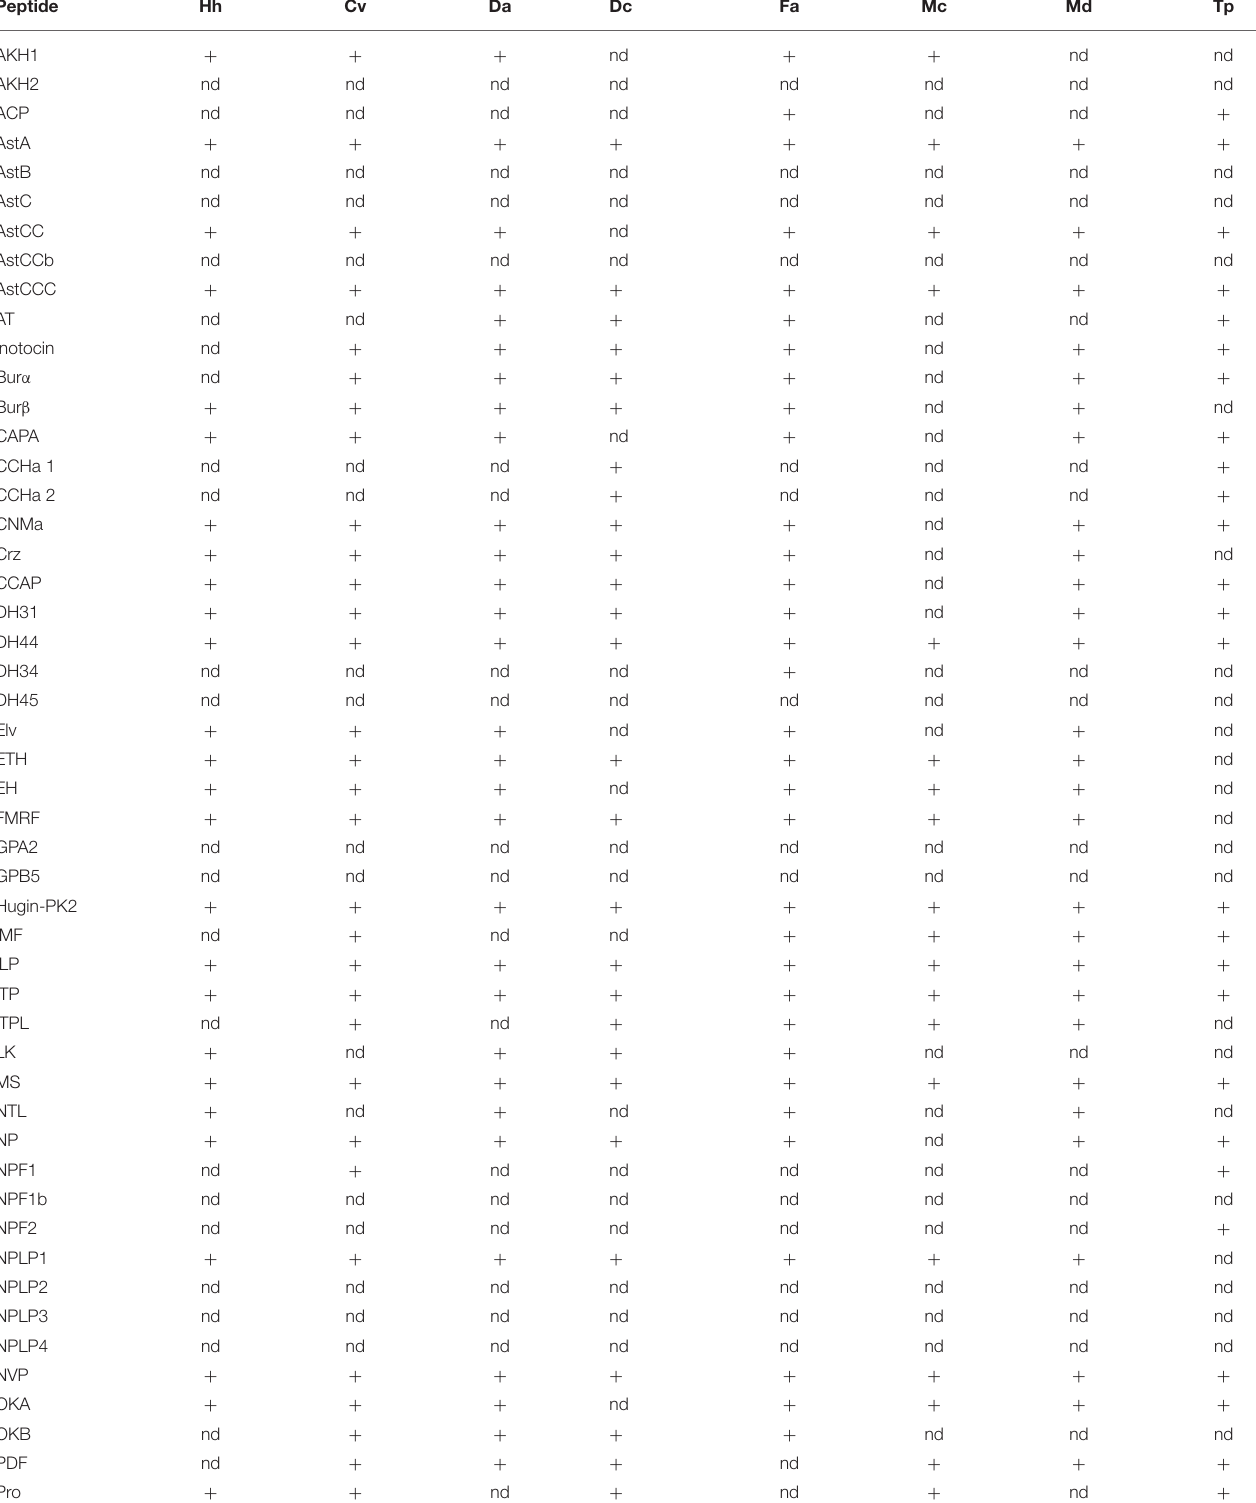
TABLE 2 | Neuropeptide genes in Braconidae species a . Peptide Hh Cv Da Dc Fa Mc Md Tp